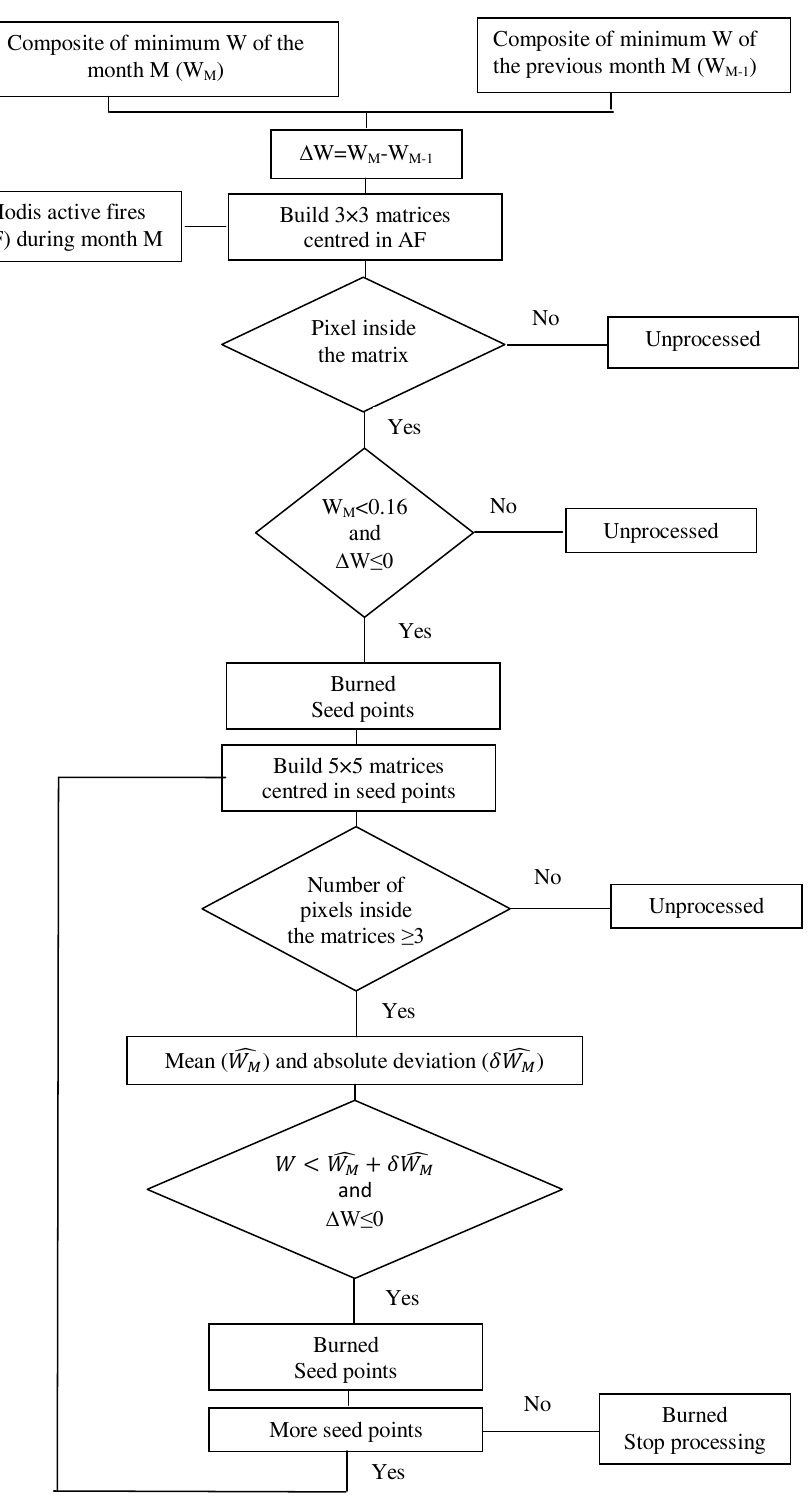
Figure 2 - Schematic flowchart showing the processing stages of the burned area